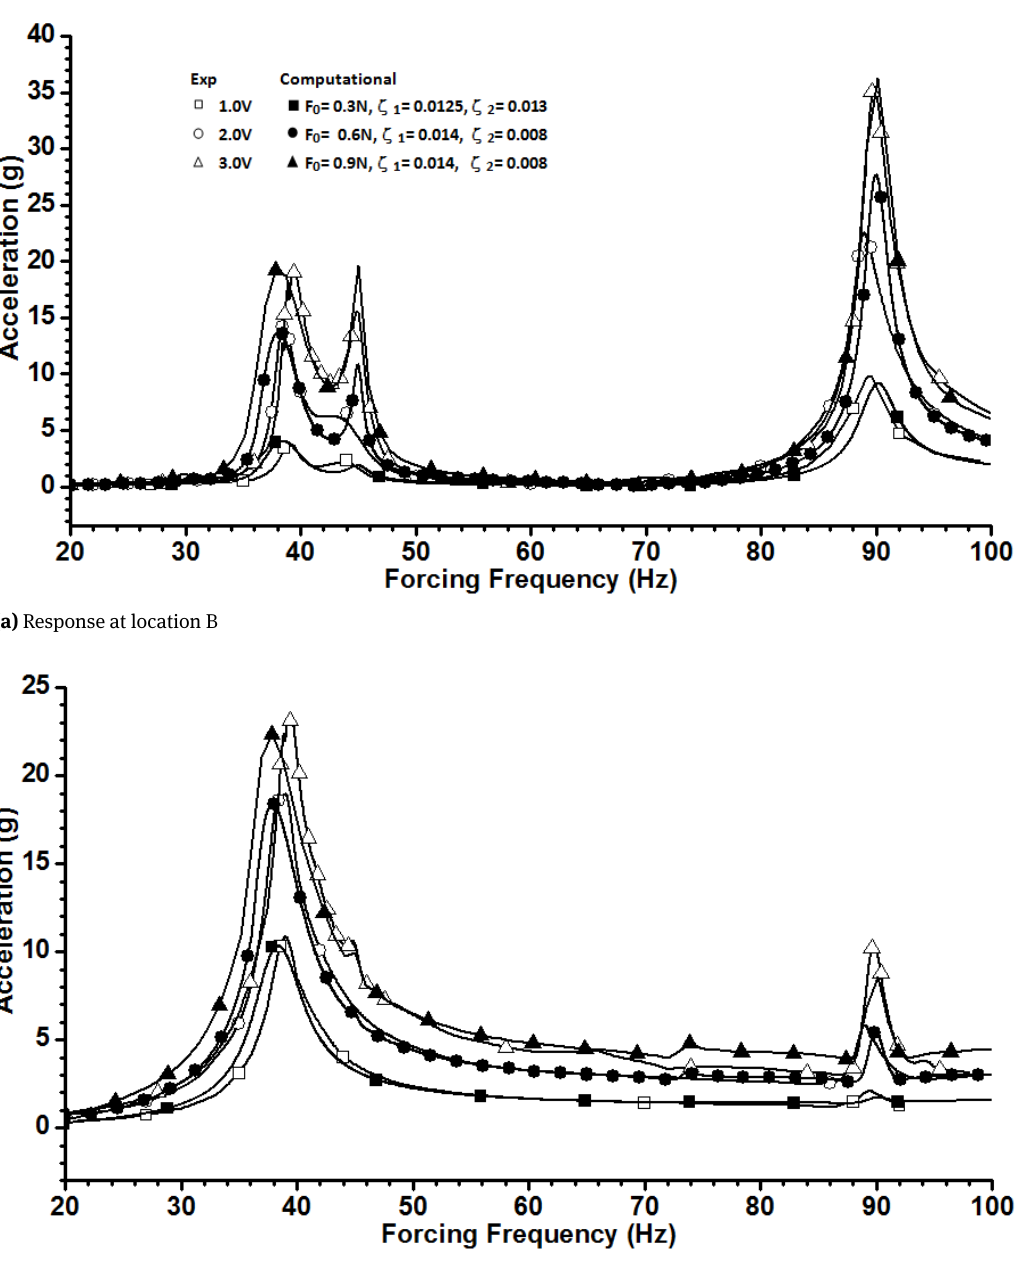
Figure 5: Acceleration versus forcing frequency curves of curved beam (span angle = 80 ∘ ) excited at location A with excitation amplitudes of 1, 2 and 3 Volts: (a) Response at B, (b) Response at A.